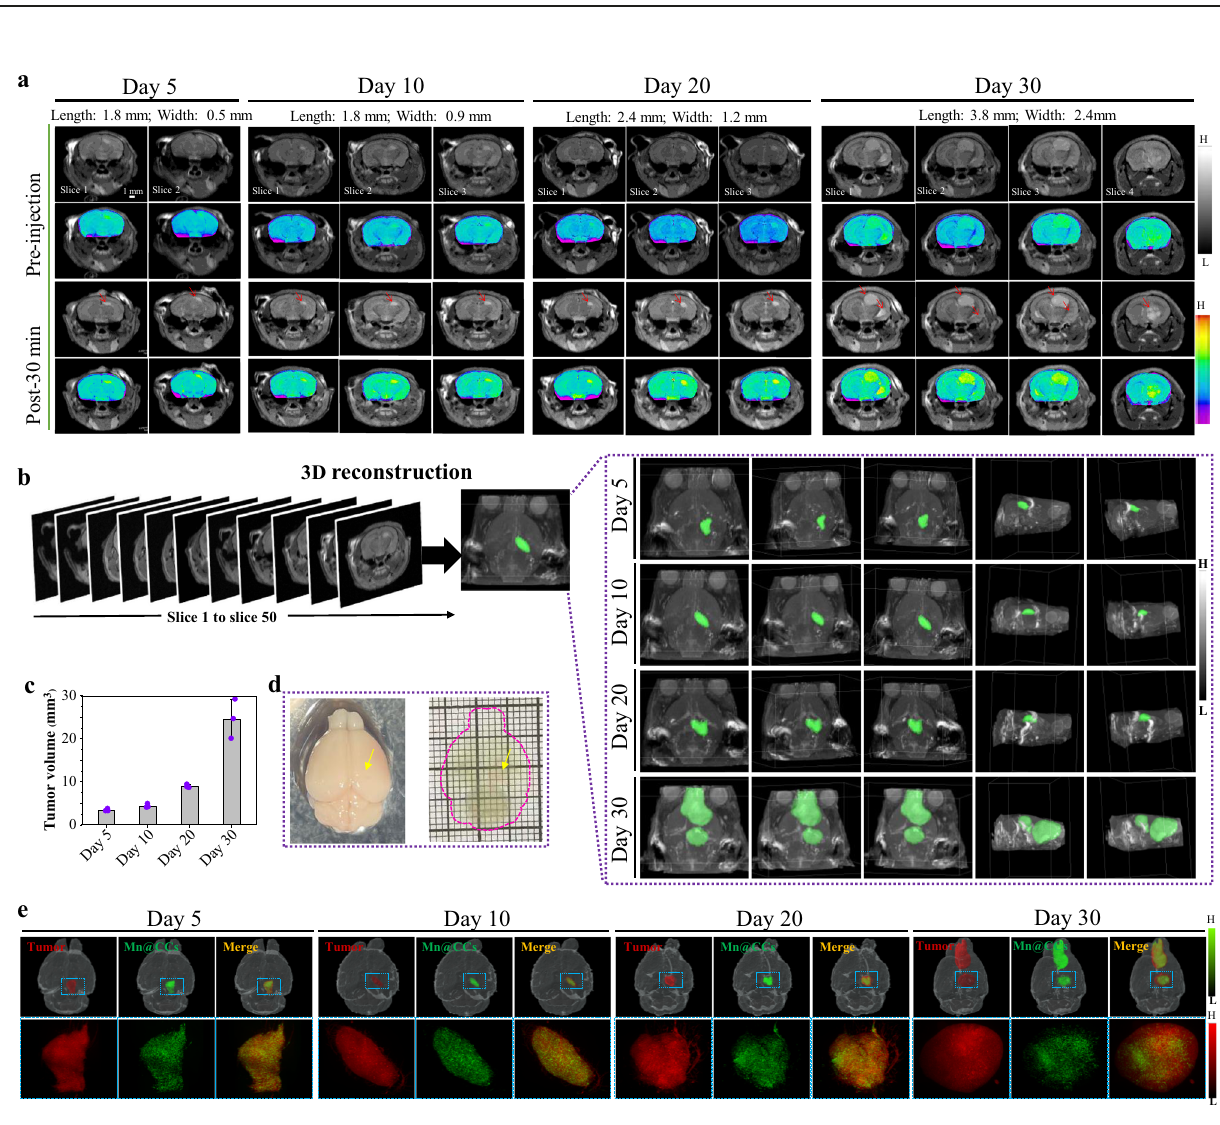
Fig. 7 3D imaging allows visualization of the distribution and penetration of Mn@CCs to tumors. a T 1 -weighted MR imaging was performed before and after injection of Mn@CCs in different stages of orthotopic GBM tumor-bearing mice ( n = 3). Day 5, Day 10, Day 20, and Day 30: The days that tumor cells were inoculated after 5, 10, 20, and 30 days to image. b 3D view constructed from Mn@CCs enhanced MRI of microscopic orthotopic gliomas (green color) in the brain tissues (gray color) under different angles. c Assessment of different early-stages different early-stages tumor volume by Amira 2020.1 (Thermo Fisher Scienti fi c, USA) and Clinical Eclipse Treatment Planning System (15.6) ( n = 3 biologically independent animals). All the statistical data are expressed as mean values ± SD. d Process of clearing and imaging brain and identi fi cation of small tumor (small arrows). e Wide- fi eld image of whole brain from orthotopic GBM tumor-bearing mice. Gray: brain tissue, red: RFP-expressed glioma, Green: Mn@CCs.